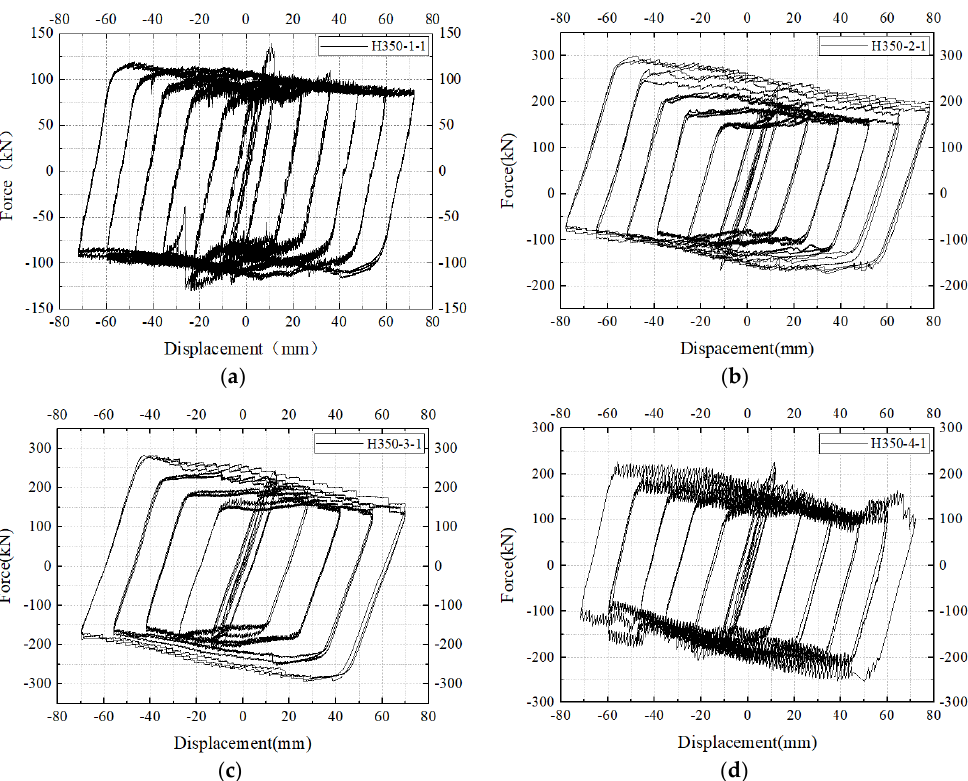
Figure 12. Force − displacement curves: ( a )H350 − 1 − 1; ( b )H350 − 2 − 1; ( c ) H350 − 3 − 1; ( d )H350 − 4 − 1. The hysteresis curves from the constant-amplitude horizontal loading test were shown in Figure 13. With the progress of cyclic loading, the horizontal force of the hydraulic actuator continues to decrease. When the test load is cycled to 10 times ∆ y 2 , the horizontal force decreases more and more slowly. When the load is cycled to 20 times ∆ y 2 , the decrease in the horizontal force is negligible. The load-carrying capacity of the specimen also decreases more and more slowly. It can also be seen from the figure that the decline rate of the load-carrying capacity of the specimen slows down after using Bes. The reason is the pressure and the Bes reduce the decrease in the pre-tension force of high-strength bolts due to the cyclic loading of large displacement. As the number of cyclic tests increase, the pre-tension force of high-strength bolts continues to decrease. When the test load is cycled to 10 times ∆ y 2 , the reduction range of the pre-tension force of high-strength bolts decreases, and the supply of pressure between arc end-plates by high-strength bolts continues to decrease. When the load is cycled to 20 times ∆ y 2 , the decrease in the pre-tension force of high-strength bolts is also negligible. At this time, although the pressure between arc end-plates is provided by axial pressure and the pre-tension force of high-strength bolts, the effect of axial pressure is greater than that of the pre-tension force of high-strength bolts. After adding brass between the arc end-plates, although the load-carrying capacity of the specimen with brass plate is reduced, the decreased rate of the load-carrying capacity of the sample is lower than that of the sample without